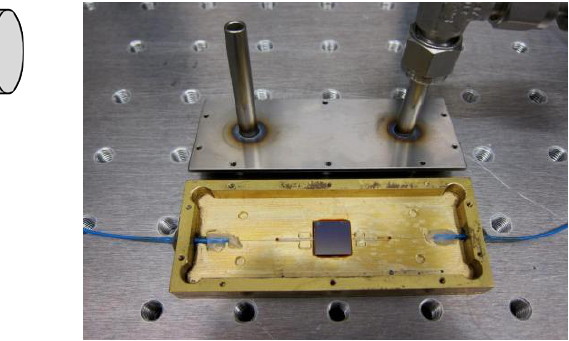
Figure 3. Schematic of the experimental setup and photo of the fiber coupled sensor.